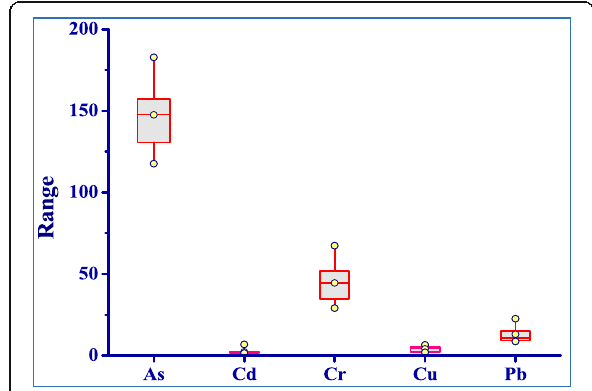
Fig. 5 Box-whisker graph showing soil heavy